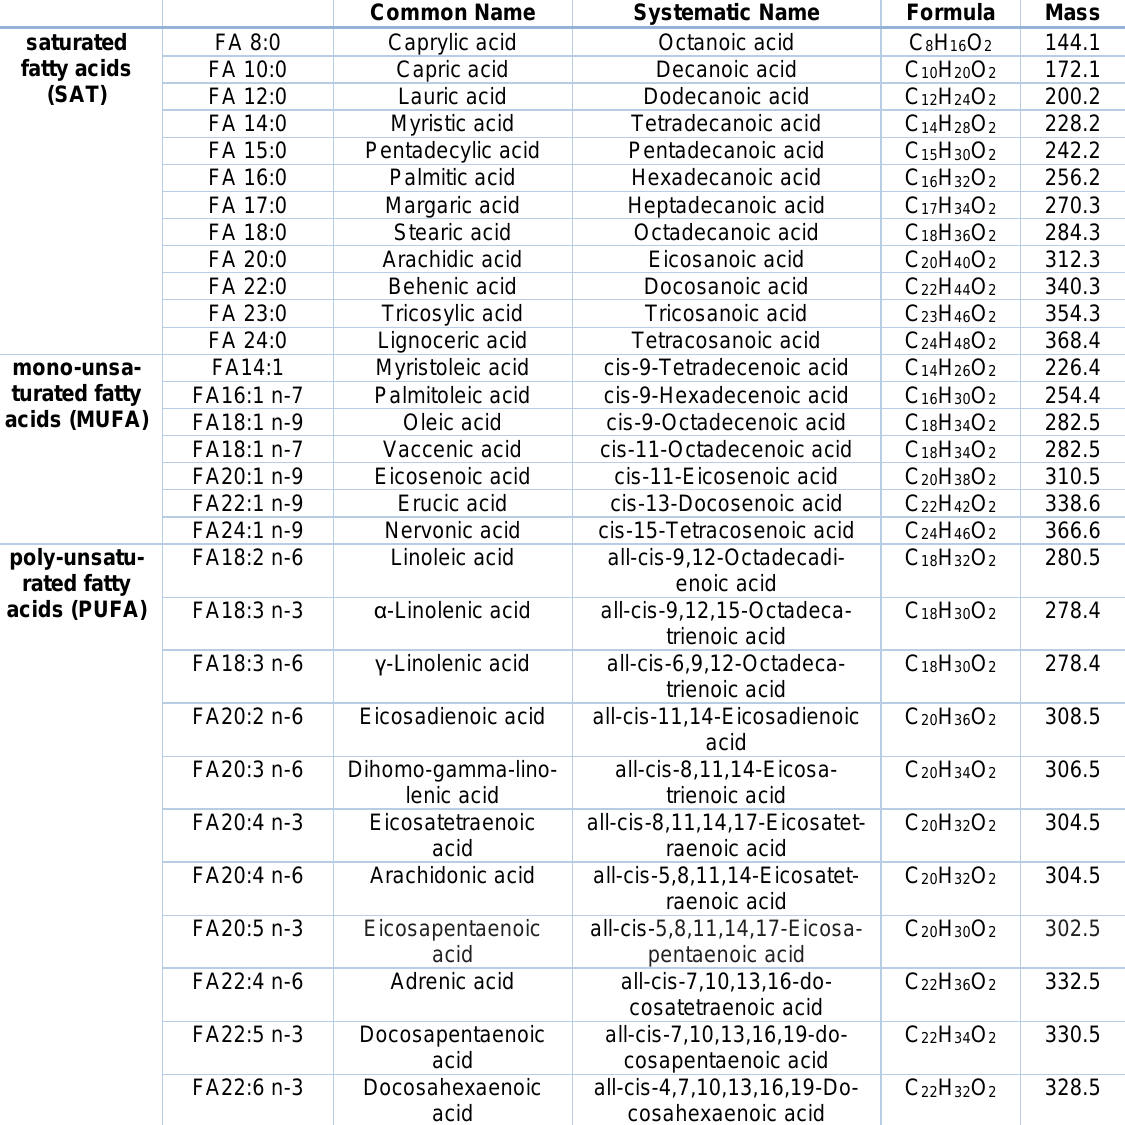
Table 1: Overview of the measured fatty